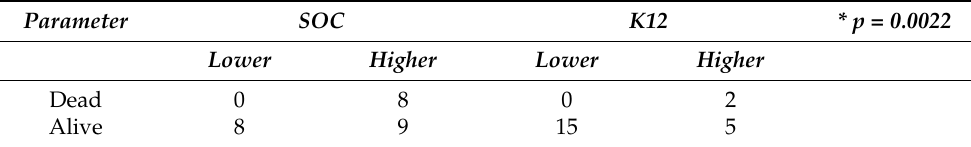
Table 6. Number of patients transferred to the ICU, recovered, or deaths. SOC (%) K12 (%) Died before being transferred to ICU 2 0 Transferred to ICU 8 8 Died in ICU 6 3 Recovery from ICU 2 5 Total deaths 8 3